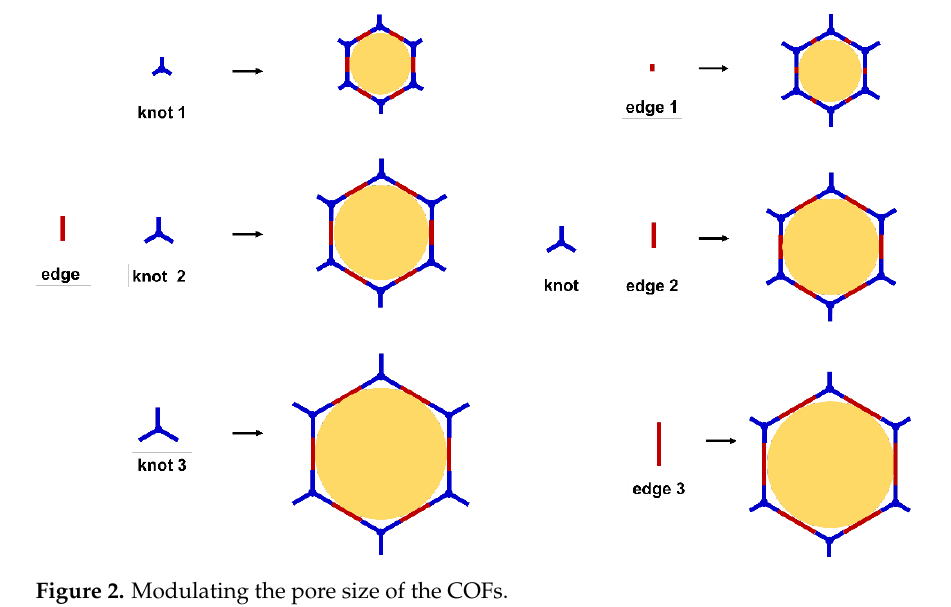
Figure 2. Modulating the pore size of the COFs.